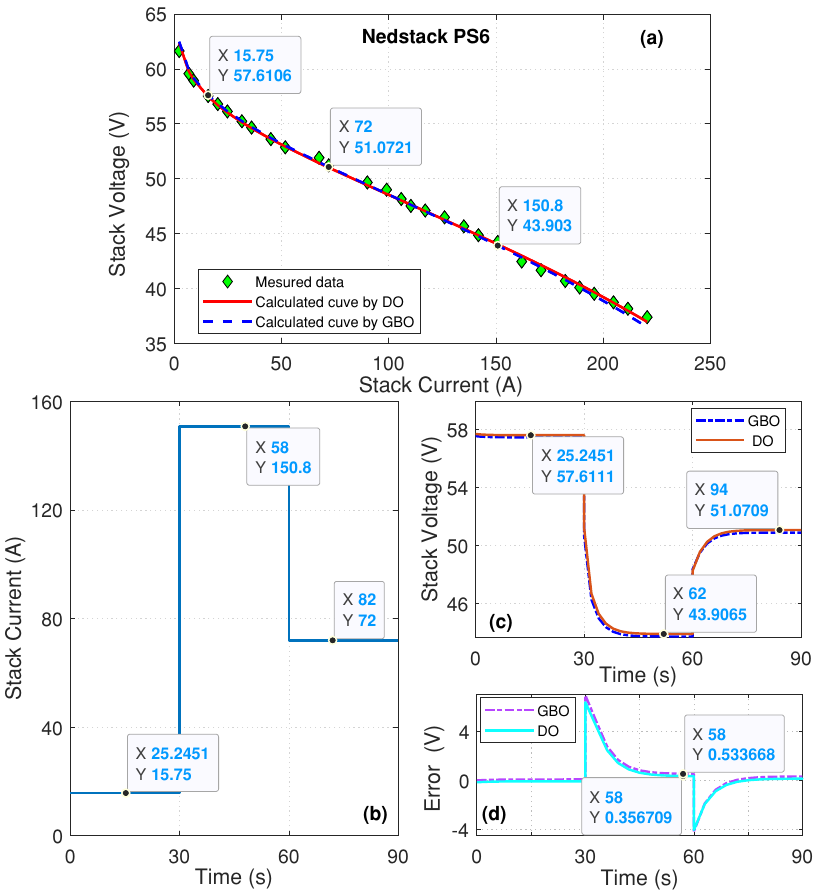
Figure 9. Characteristic and dynamic simulations of the PS6 stack: ( a ) I–V polarisation; ( b ) stack load current changes; ( c ) stack voltage responses; ( d ) voltage